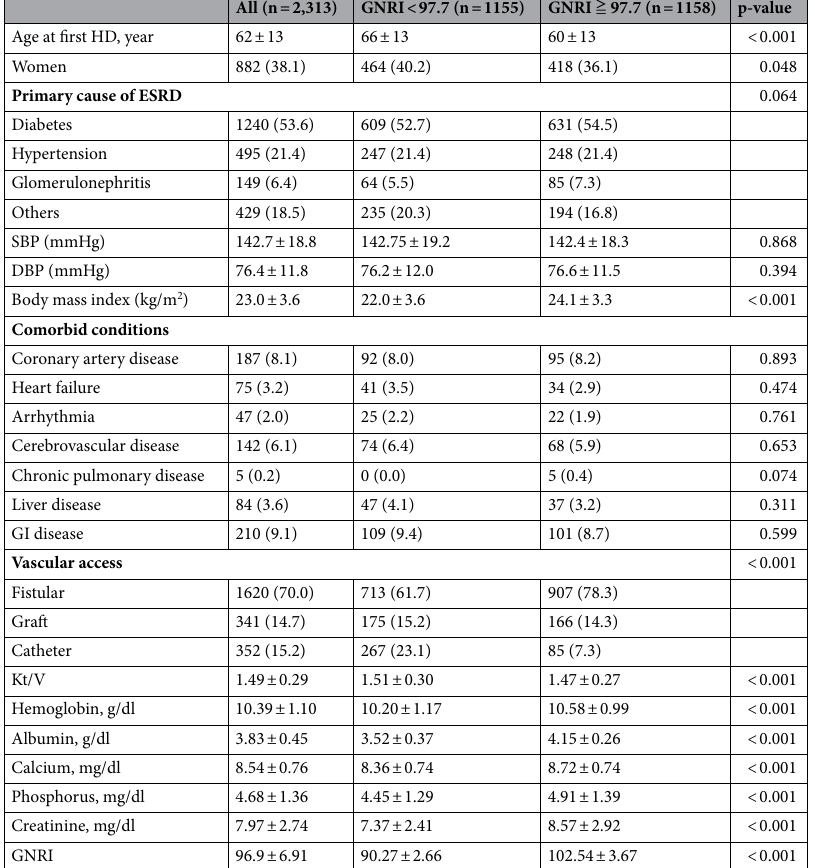
Table 1. Baseline characteristics by median GNRI value. Data are number (percentage) and mean ± standard deviation. HD hemodialysis, SBP systolic blood pressure, DBP diastolic blood pressure, ESRD end-stage renal disease, GI gastrointestinal, GNRI geriatric nutrition risk